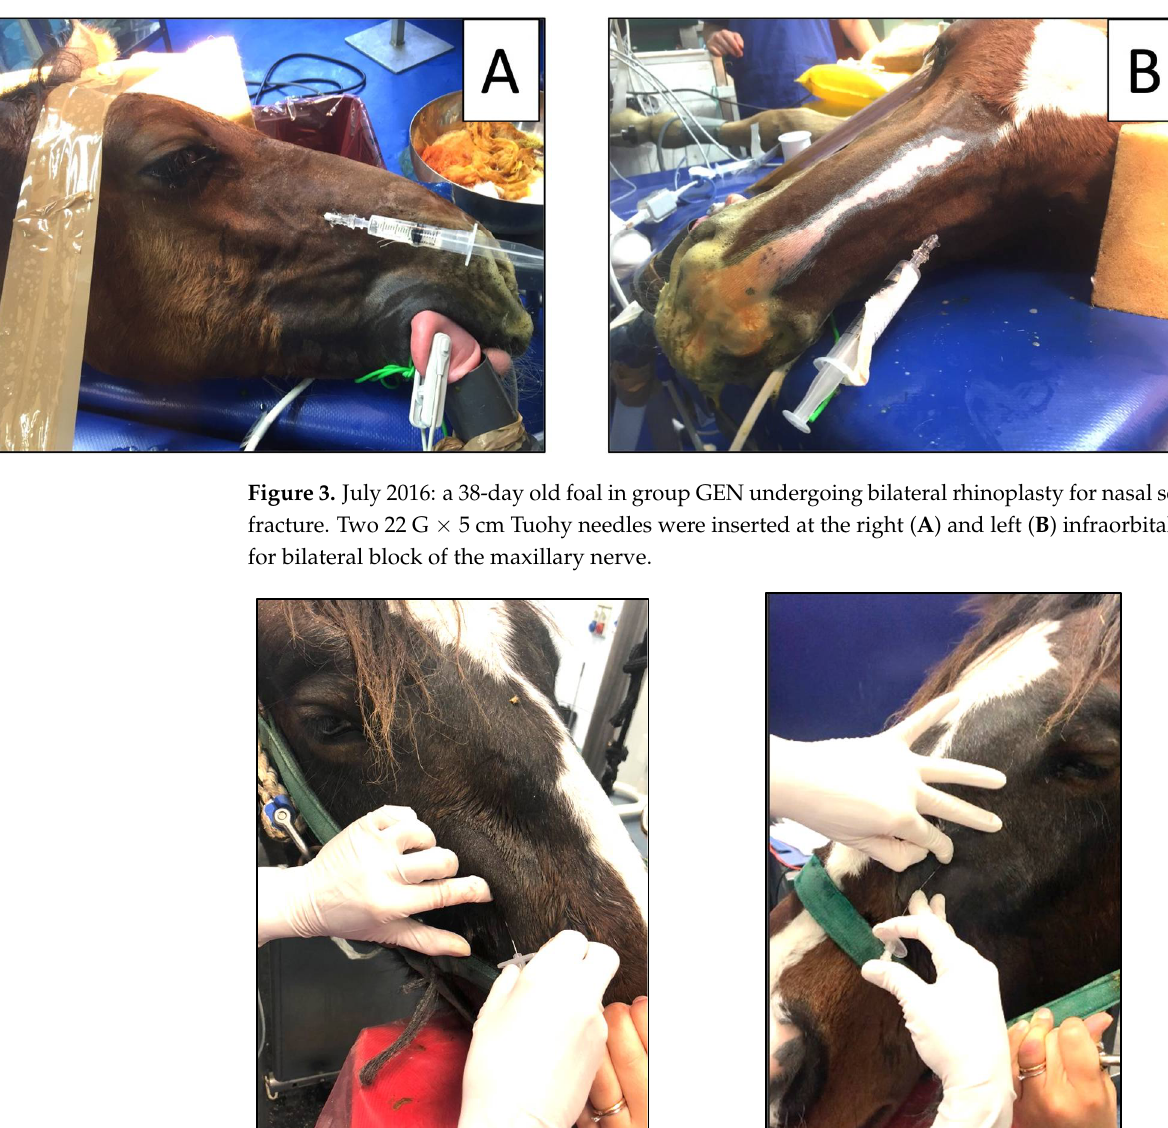
Figure 2. March 2014: a 17-year-old mare in group STA undergoing maxillary sinus trephination and dental root curettage. Horse was restrained in a stock, sedated and with the head sustained by a headrest. Subcutaneous injection of 1–2 mL 2% lidocaine at the infraorbital foramen ( A ); sliding of a 20 G × 5 cm Tuohy needle into the infraorbital canal with the bevel oriented laterally ( B ); injec- tion of 10 mL local anesthetic after withdrawn of the stylet and needle aspiration to exclude any vessel puncture ( C ); surgical procedure ( D ).